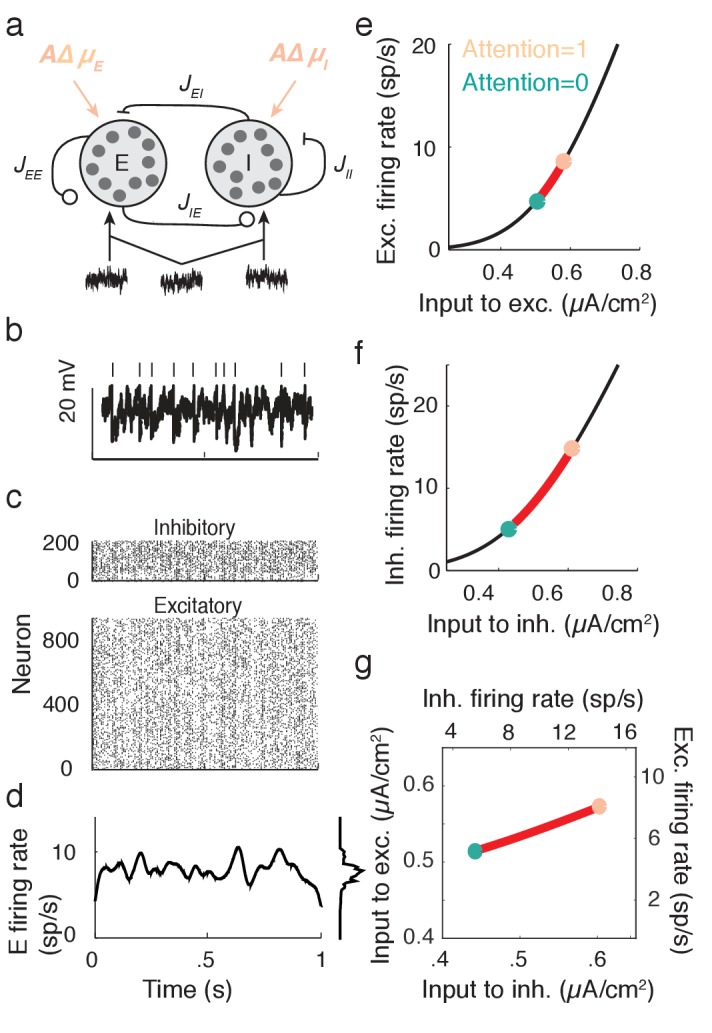
Excitatory-inhibitory network model.(a) Recurrent excitatory-inhibitory network subject to private and shared fluctuations as well as top-down attentional modulation. (b) Example voltage trace from a LIF model neuron in the network. Top tick marks denote spike times. (c) Spike time raster plot of the spiking activity from the model network. (d) Population-averaged firing rate rE⁢(t) of the excitatory population. Left: frequency distribution of population-averaged firing rate. (e) Transfer function fE between the effective input and the firing rate for a model excitatory neuron. The red segment represents the attentional shift in effective input and hence firing rate. (f), Same as e, but for the inhibitory population. (g) Attention as a path through (r¯E,r¯I) space, and equivalently through (IEeff, IIeff) space.